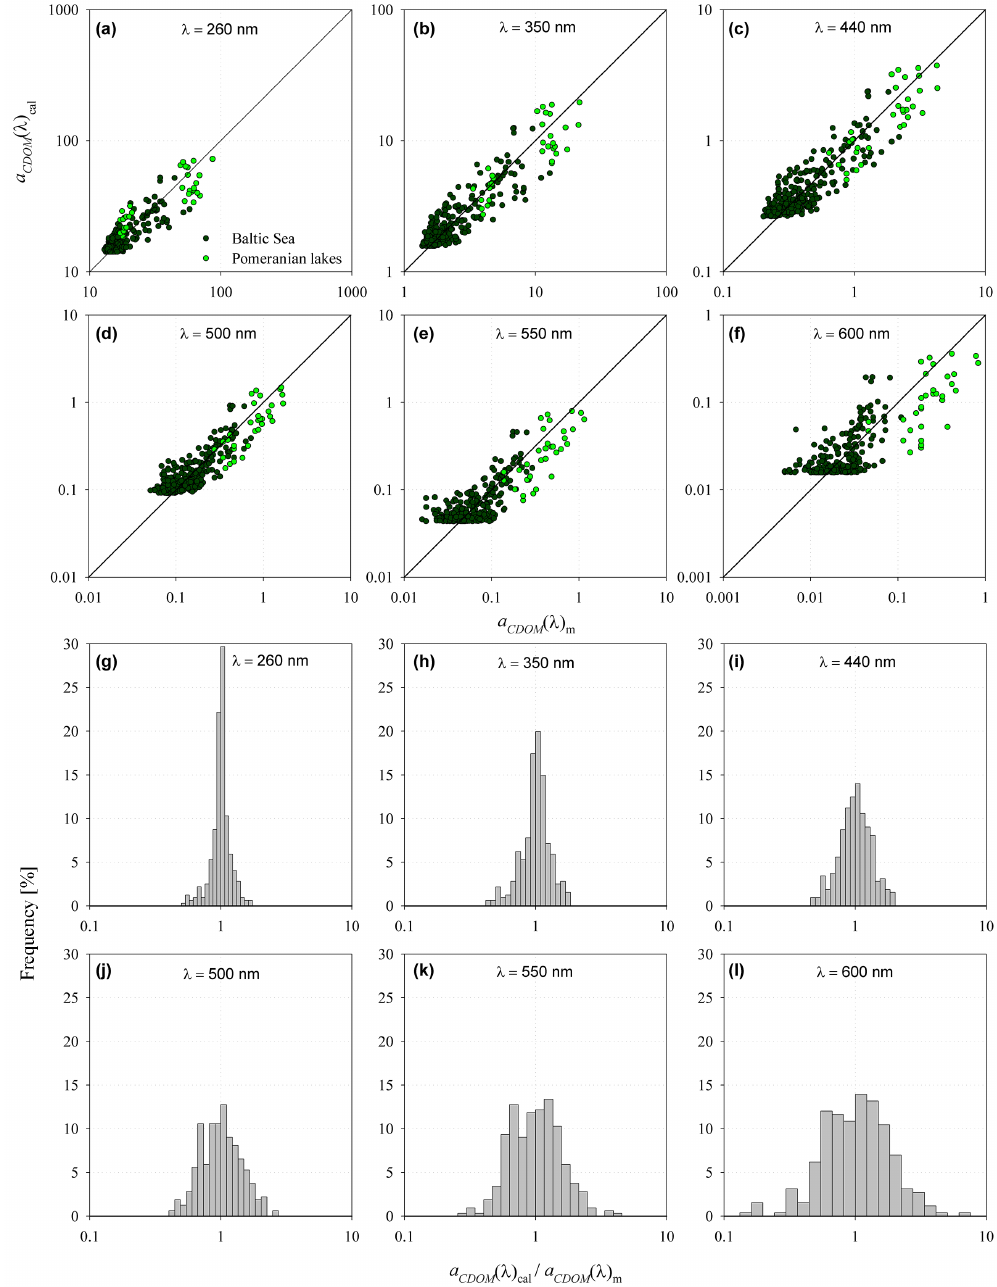
Figure 5. Comparison of light absorption coefficients measured ( a CDOM (λ) m ) and calculated ( a CDOM (λ) cal ) using model (Eq. 13) in the Baltic (black dots) and Pomeranian lakes (green dots) for selected wavelengths: (a) 260nm; (b) 350nm; (c) 440nm; (d) 500nm; (e) 550nm; (f) 600nm. The solid line shows the function a CDOM (λ) cal = a CDOM (λ) m . The probability density distributions of the ratio of calculated a CDOM (λ) cal to measured a CDOM (λ) m light absorption coefficients for selected wavelengths: (g) 260nm; (h) 350nm; (i) 440nm; (j) 500nm; (k) 550nm; (l)